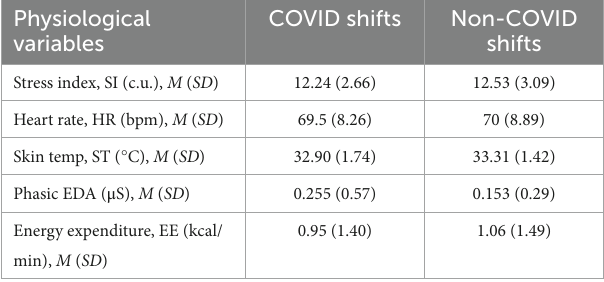
TABLE 4 Descriptive statistics of physiological variables of MICU participants working COVID and non-COVID